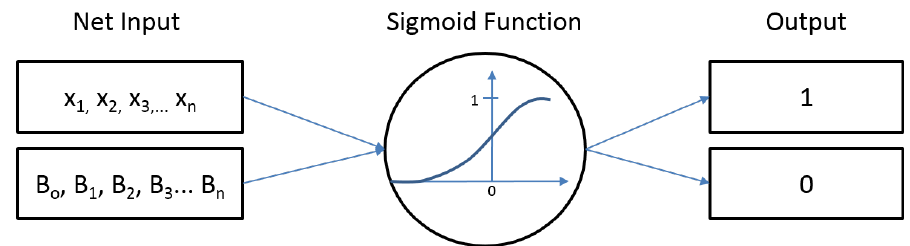
Figure 3. Architecture of a logistic regression model.